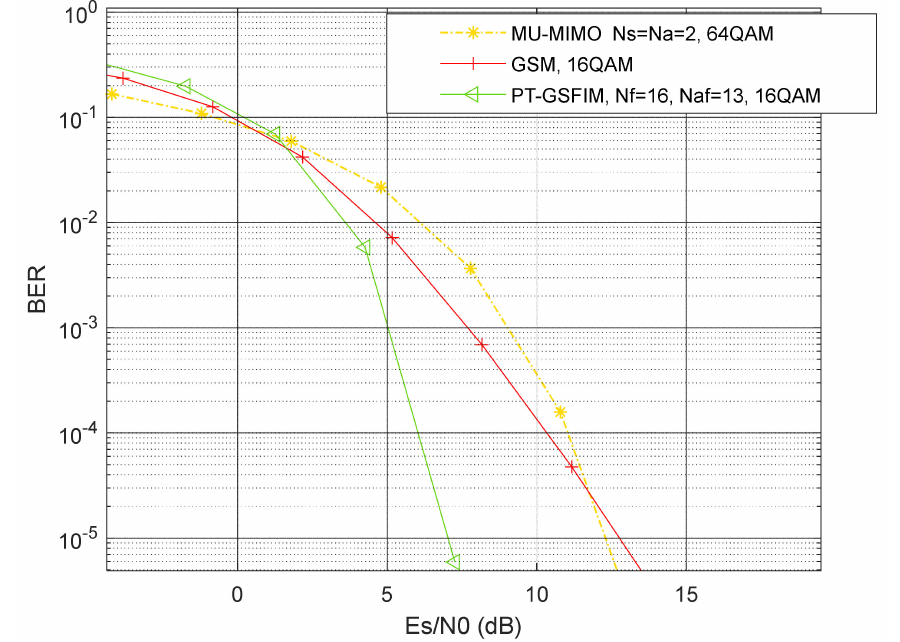
Figure 4. Comparison of BER performances of PT-GSFIM, GSM and conventional BD MU-MIMO, with N u = 8 and SE = 12 bpcu.